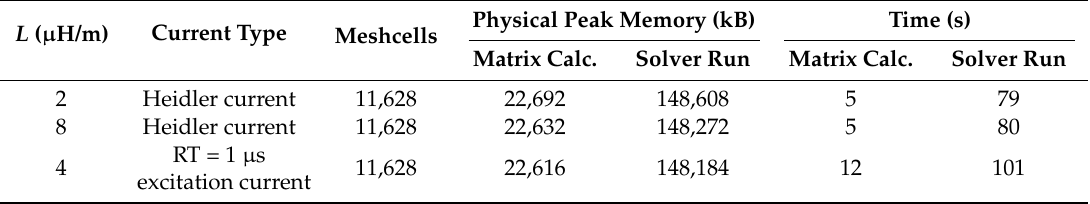
Table 4. Model C : Wire in free-space loaded by distributed series inductance and resistance. Computational time and memory resources.